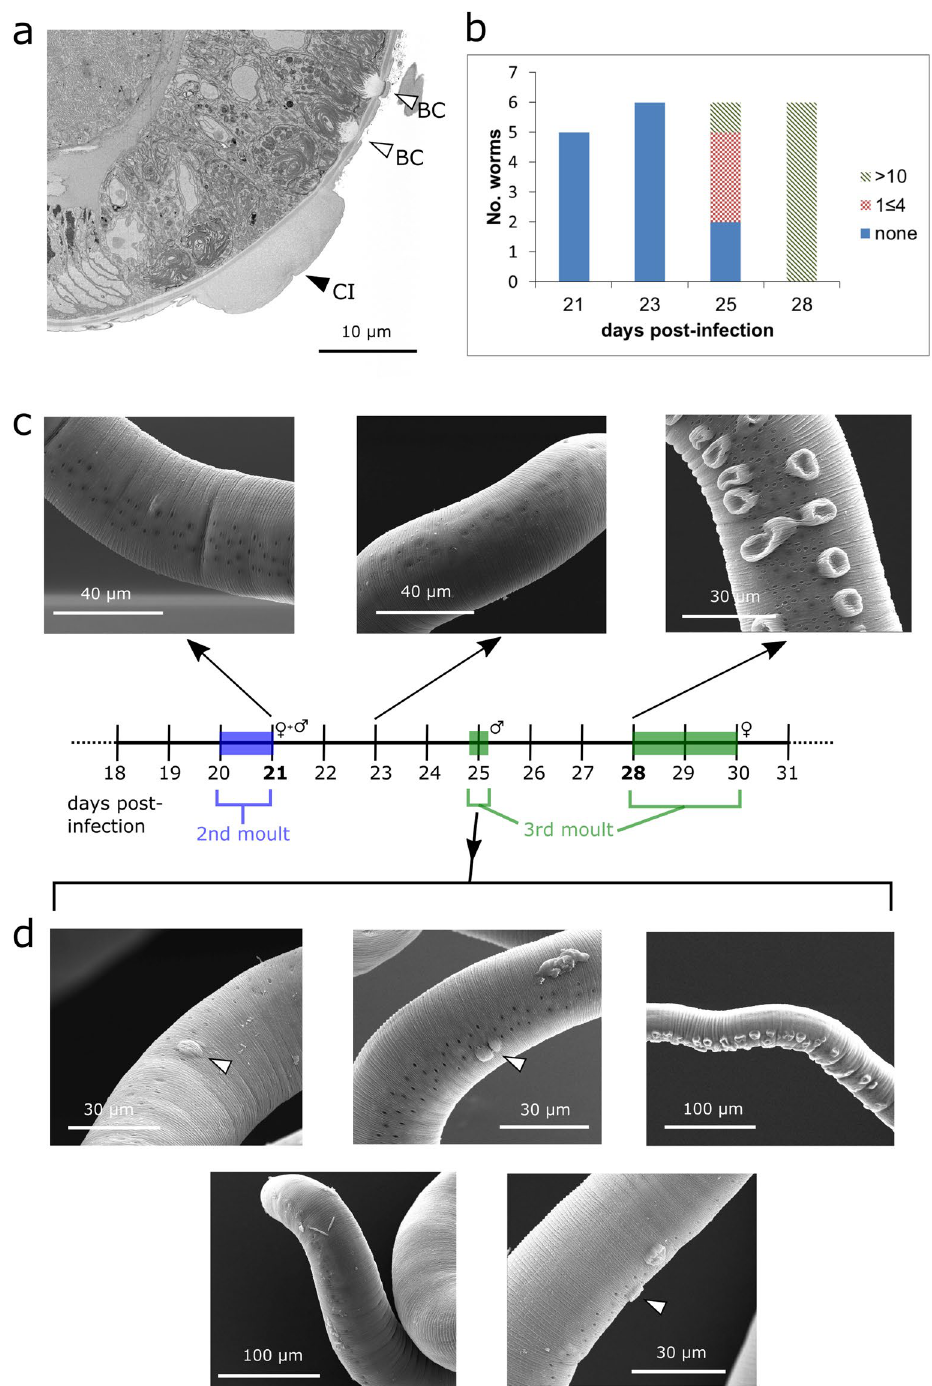
Figure 1. A developmental time-course of cuticular inflations generated using SEM. ( a ) Backscattered electron SEM cross section of adult T. muris after heavy metal staining and resin-embedding, showing the surface- projecting cuticular inflation (CI), as well as the sub-surface bacillary cells (BC). ( b ) Histogram of SEM data showing frequency of worms exhibiting no inflations, between 1 and 4 inflations, and more than 10 inflations at time-points during development. ( c ) Example SEM images from worms 21, 23, 25 and 28 days PI. No inflations can be seen at day 21 and 23 PI. At day 28 post-infection, all worms exhibited more than 10 cuticular inflations. ( d ) At 25 days PI three worms showed one or two inflations (◀), in contrast with one worm which had none and another which exhibited many